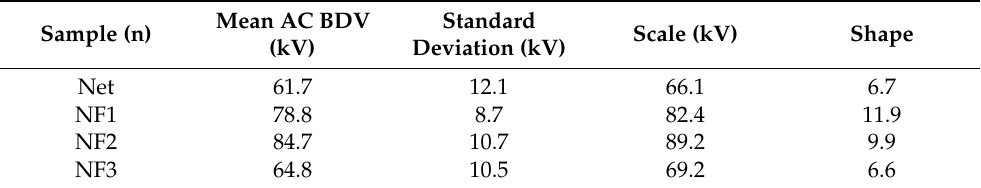
Table 2. Descriptive statistics of the liquid samples under